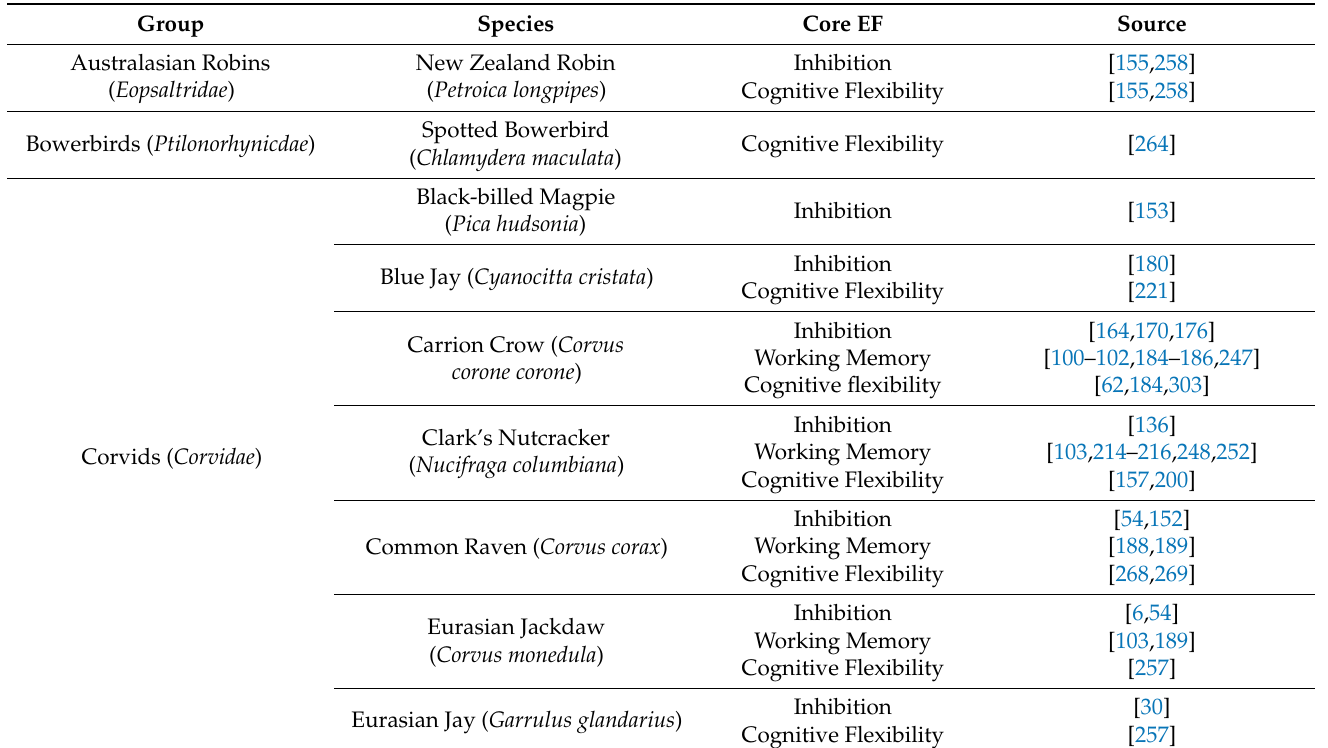
Table 3. Overview of the bird species that have been involved in EF